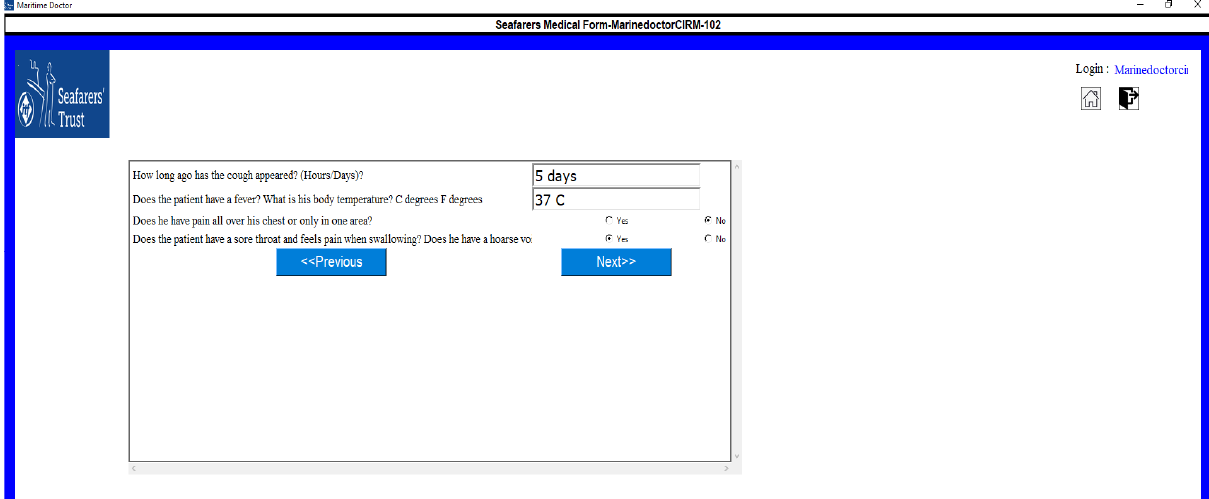
Figure 5. Display of symptomatic questionnaire.